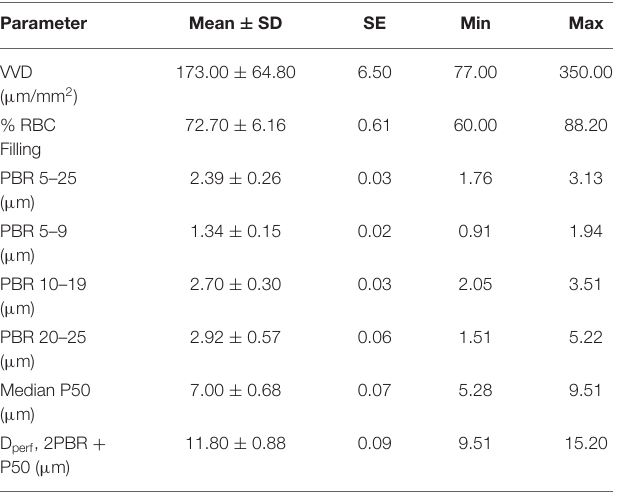
TABLE 2 | GlycoCheck ® parameters in a population of healthy cats ( n = 101). Parameter